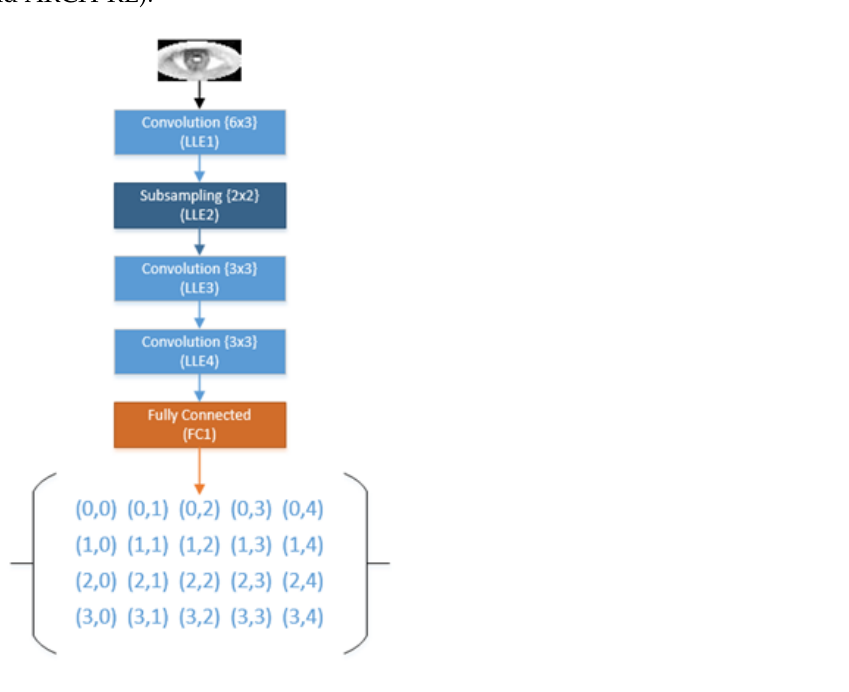
Figure 5. Network architecture for the network processing images with one eye (ARCH-LE and